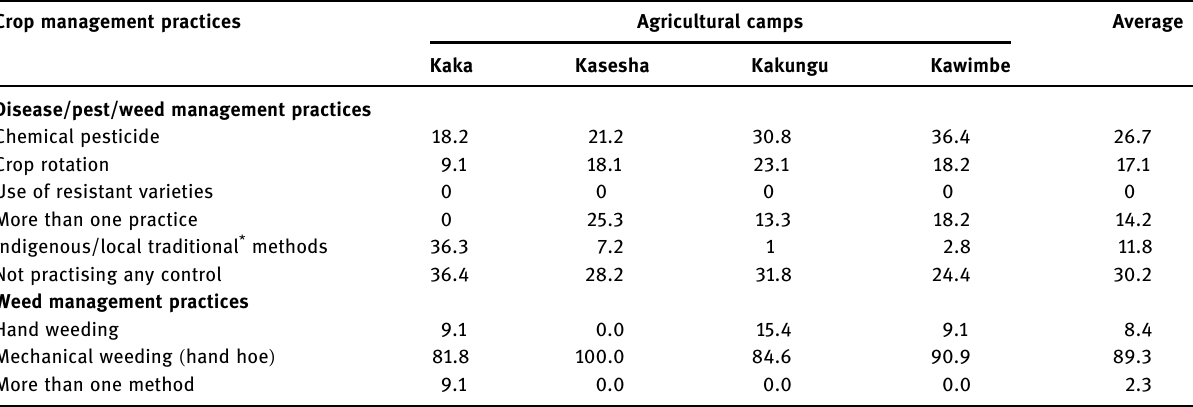
Table 7: Farmer crop management practices ( % respondents ) Crop management